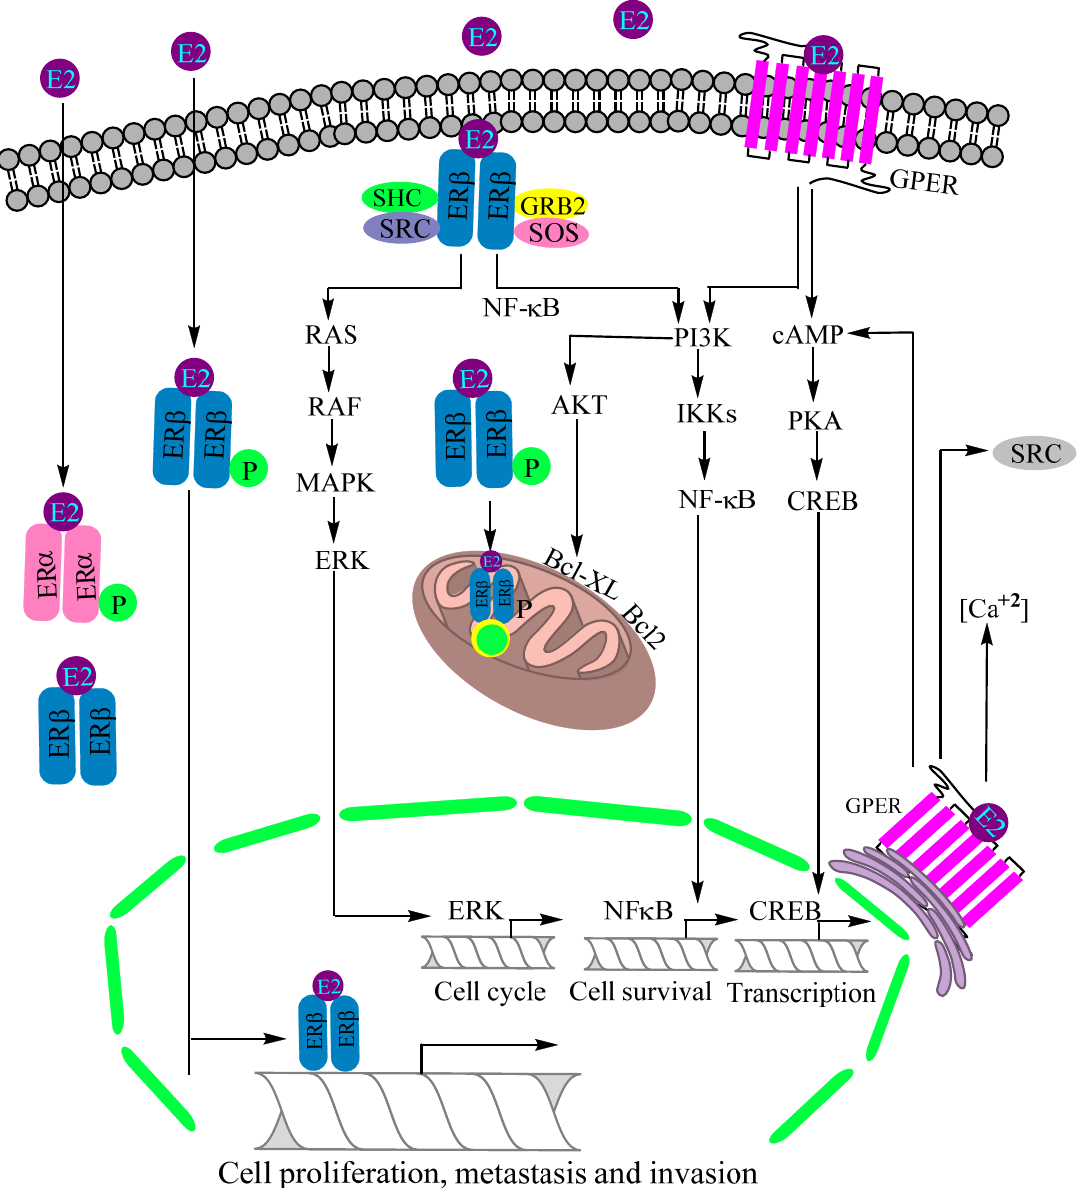
Figure 3. Recognized mechanisms of estrogen receptor (ER)-mediated lung cancer progression. Estrogen receptor β (ER β ) is the major estrogen receptor expressed in lung cancer, prevailing in cytoplasm, nucleus and mitochondria. The PI3K/IKK/NF κ B, PI3K/AKT/Bcl-XL and RAS/RAF/MAPK/ERK are the activated signaling pathways for regulatory control of cell proliferation, invasion, metastasis, mitochondrial biogenesis and apoptotic suppression. The G-protein estrogen receptor (GPER) is activated by estradiol (E2) binding to intercept the cAMP/PKA/CREB and PI3K/IKK/NF κ B signaling pathways, together modulating a neoplastic transformation. Abbreviations: PKA: Protein kinase A, CREB: cAMP response-element-binding protein, IKK: Inhibitor of nuclear factor- κ B (I κ B) kinase, MAPK: Mitogen-activated protein kinase, ERK: Extracellular signal-regulated kinase, AKT: Protein kinase B, SRC: Steroid receptor coactivator, SHC: SHC-transforming protein 1, GRB2: Growth factor receptor-bound protein 2, SOS: DNA repair system.